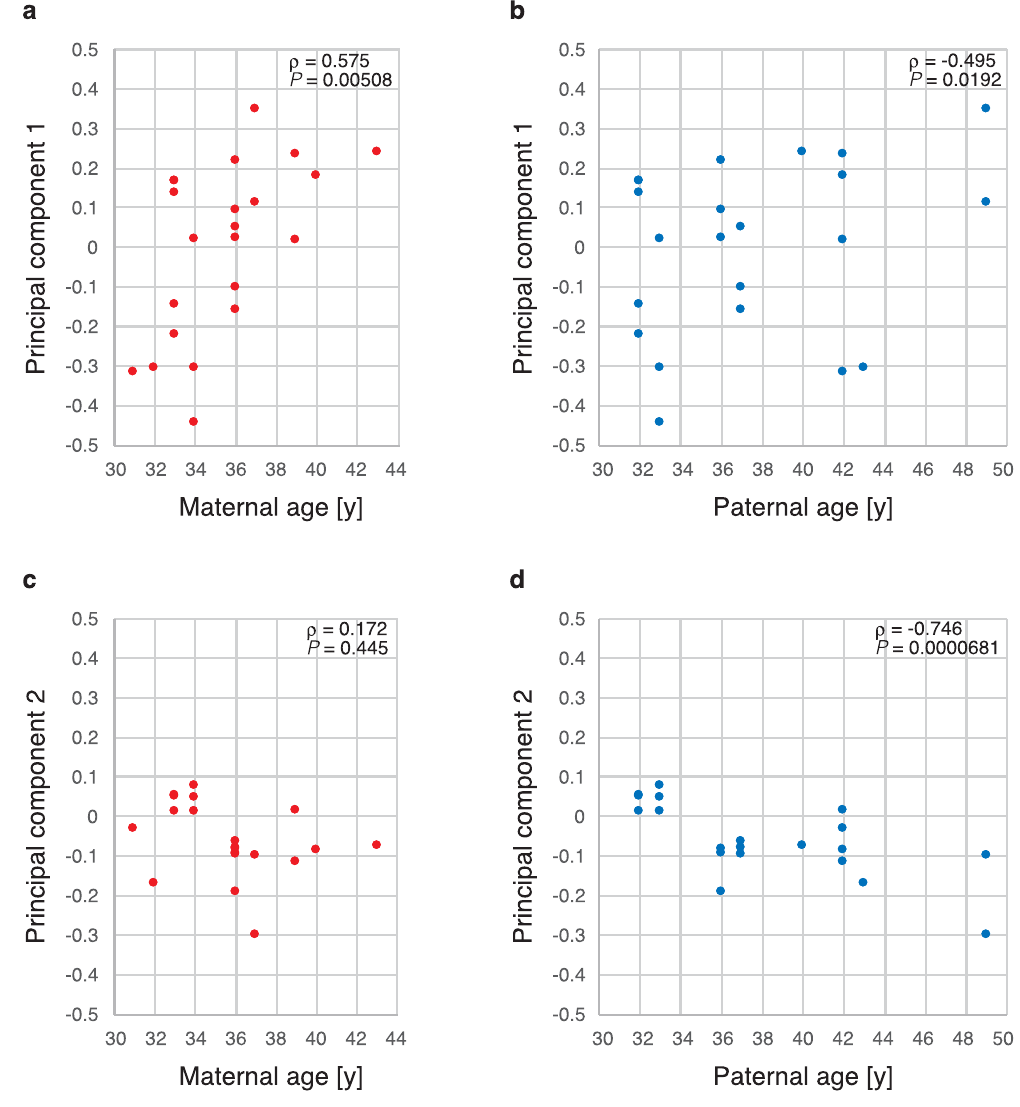
Figure 1. Parental age and gene expression profiles. PCs of the human blastocyst gene expression data were plotted against the maternal or paternal age. ( a ) The first PC and maternal age, Spearman’s ρ = 0.575, P = 0.00508. ( b ) The first PC and paternal age, Spearman’s ρ = 0.172, P = 0.445. ( c ) The second PC and maternal age, Spearman’s ρ = − 0.495, P = 0.0192. ( d ) The second PC and paternal age, Spearman’s ρ = − 0.746, P =